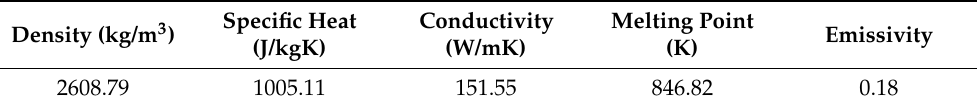
Table 3. Material